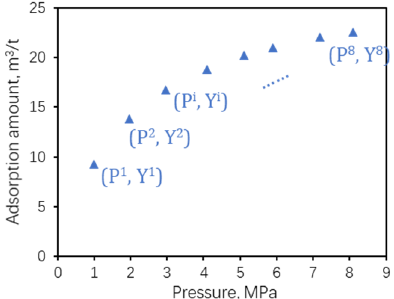
Figure 3. An example of the experimentally measured adsorption isotherm represented with discrete equilibrium points. P i and Y i represent the equilibrium pressure and the corresponding adsorption amount for the ith equilibrium points.